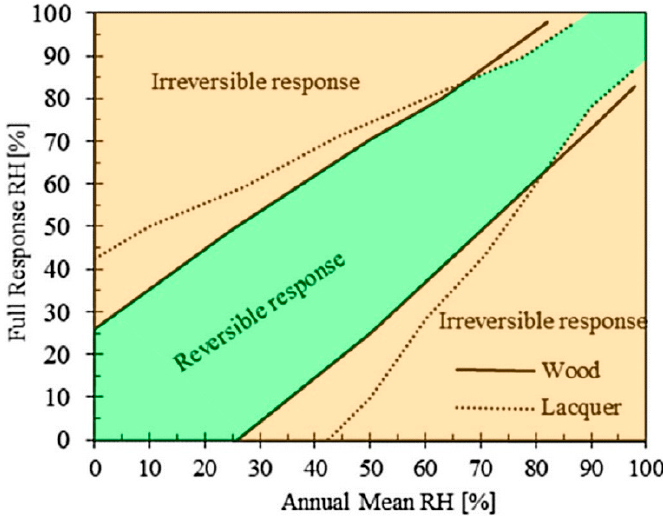
Figure 4. Mechanical risk assessment for lacquered wood furniture. The green and orange areas indicate conditions with a low and medium risk of deterioration respectively. Adapted from [57].